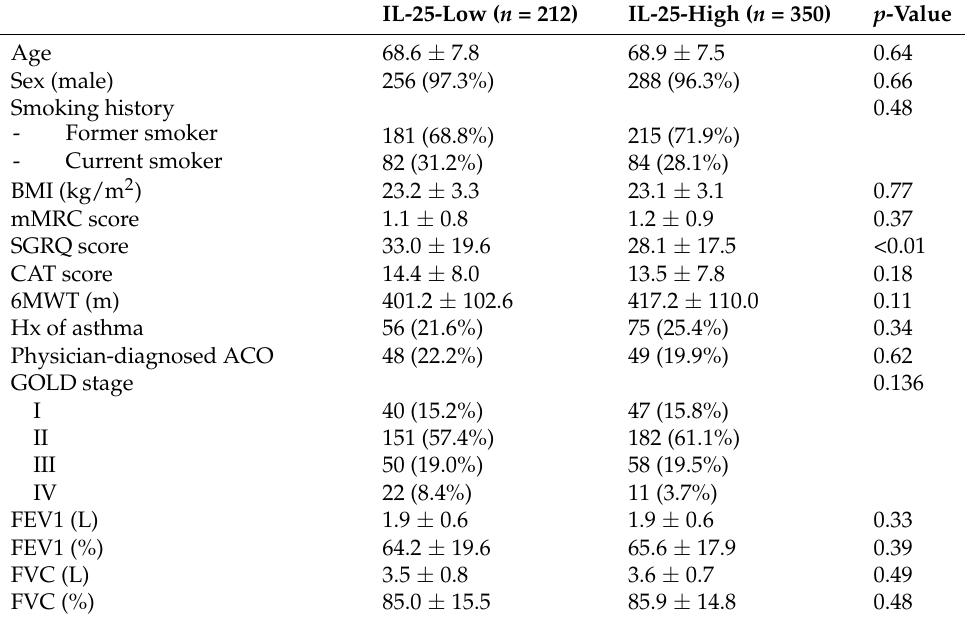
Table 2. Differences in the clinical characteristics between IL-25-low/high